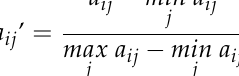
Figure 7. Selected maximum response value, peak area, maximum first-order derivative, maximum second-order derivative.